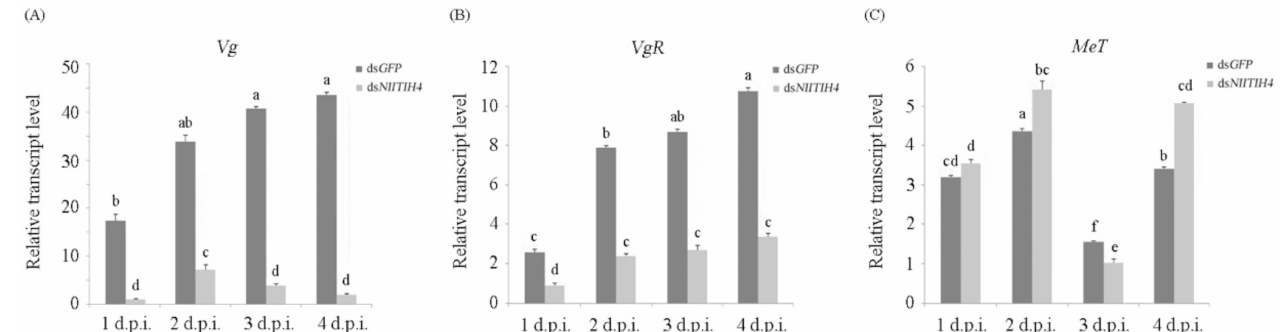
Figure 6. Effects of RNAi on the transcription levels of Vg ( A ), VgR ( B ), MeT ( C ) at 1 to 4 days post injection of dsRNA (d.p.i.). Data are expressed as mean ± SE. Significant difference: different lower-case letters above the bars indicate significant differences for which p <